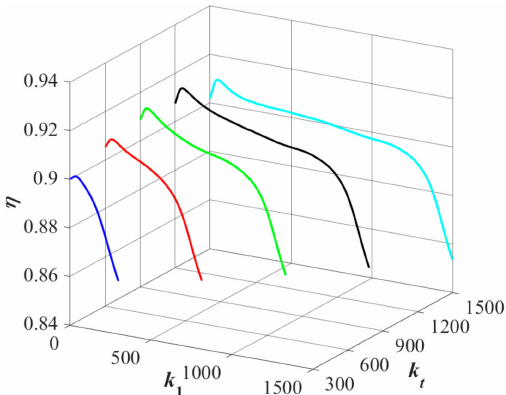
Figure 16. The variation of efficiency of the five NESs with the stiffness of N 1 .